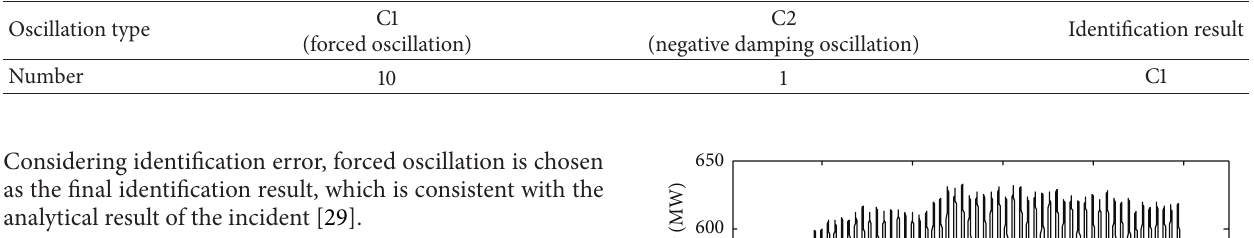
Table 2: Identification result of oscilloscope records of forced oscillation incidence.